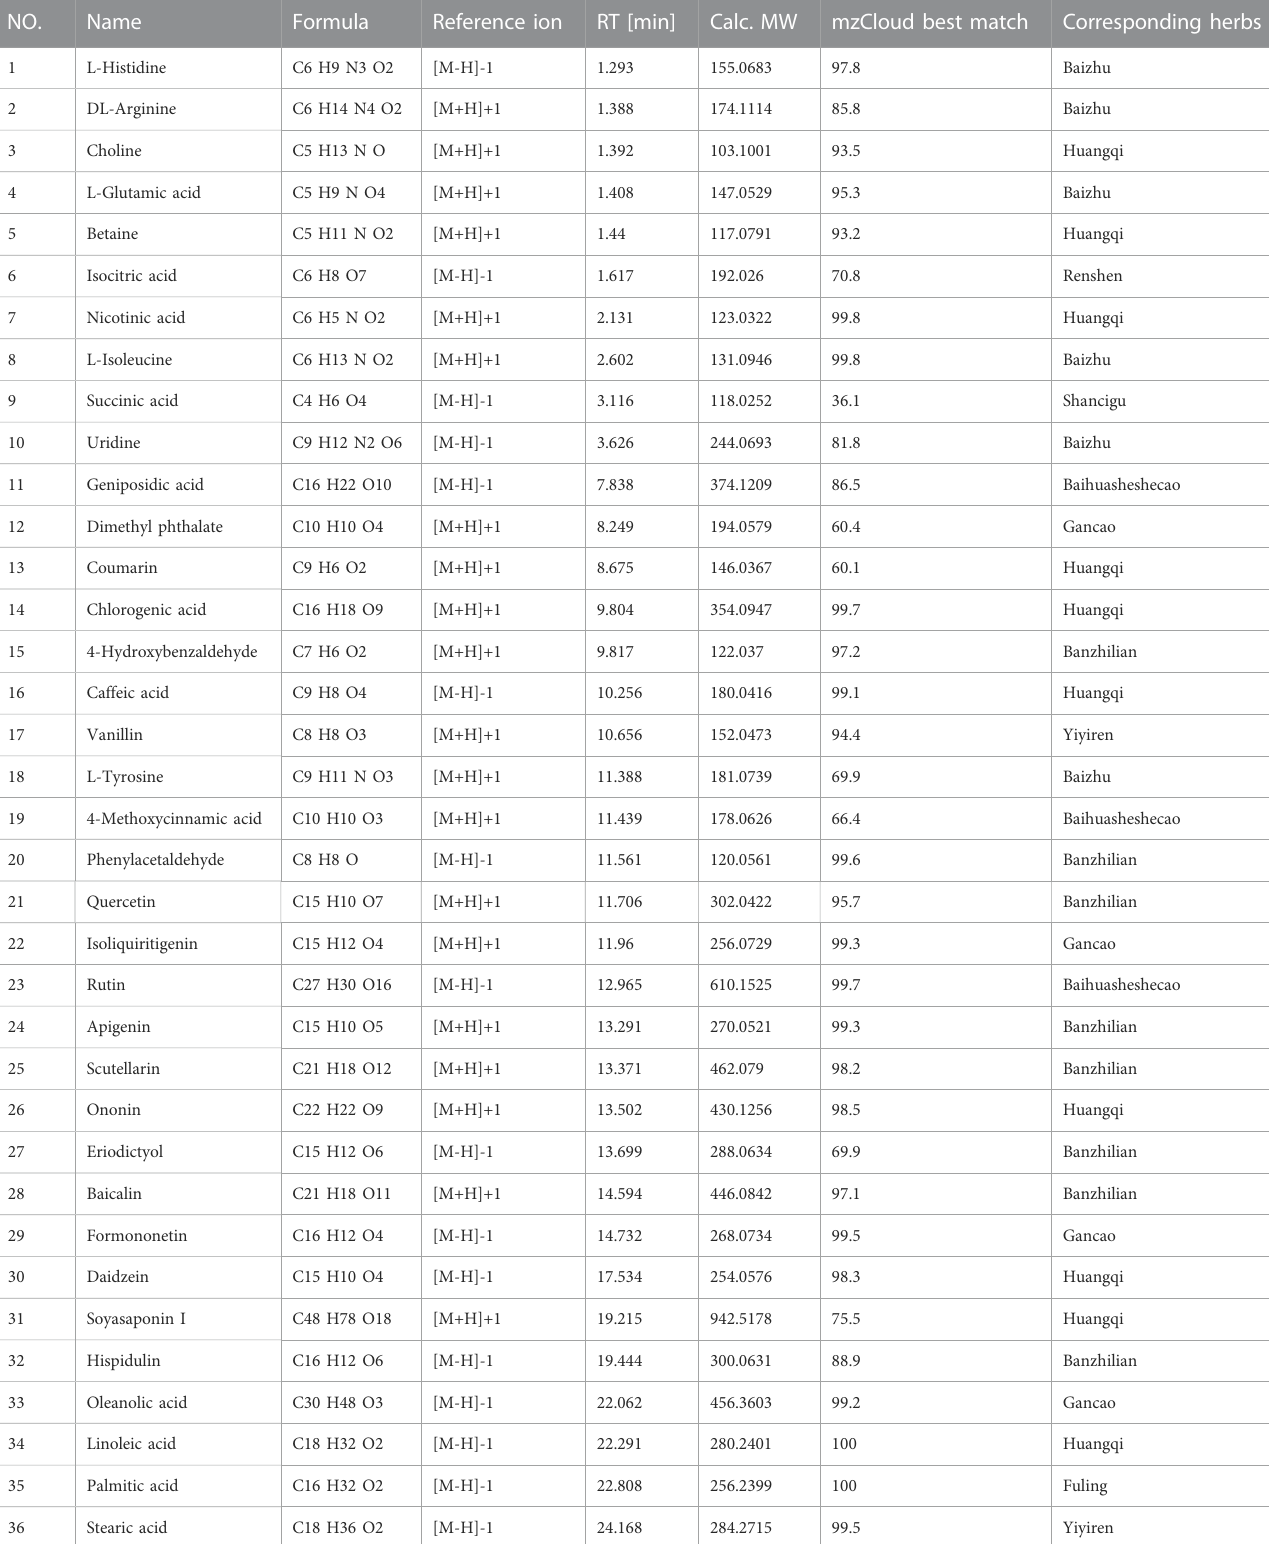
TABLE 2 Chemical composition information in